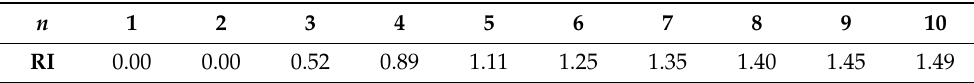
Table 7. Saaty’s random index [38].